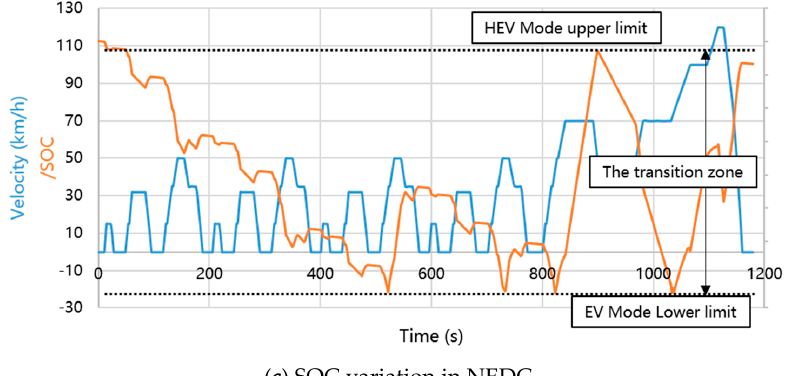
Figure 6. Qin Plus charge sustaining process simulation.